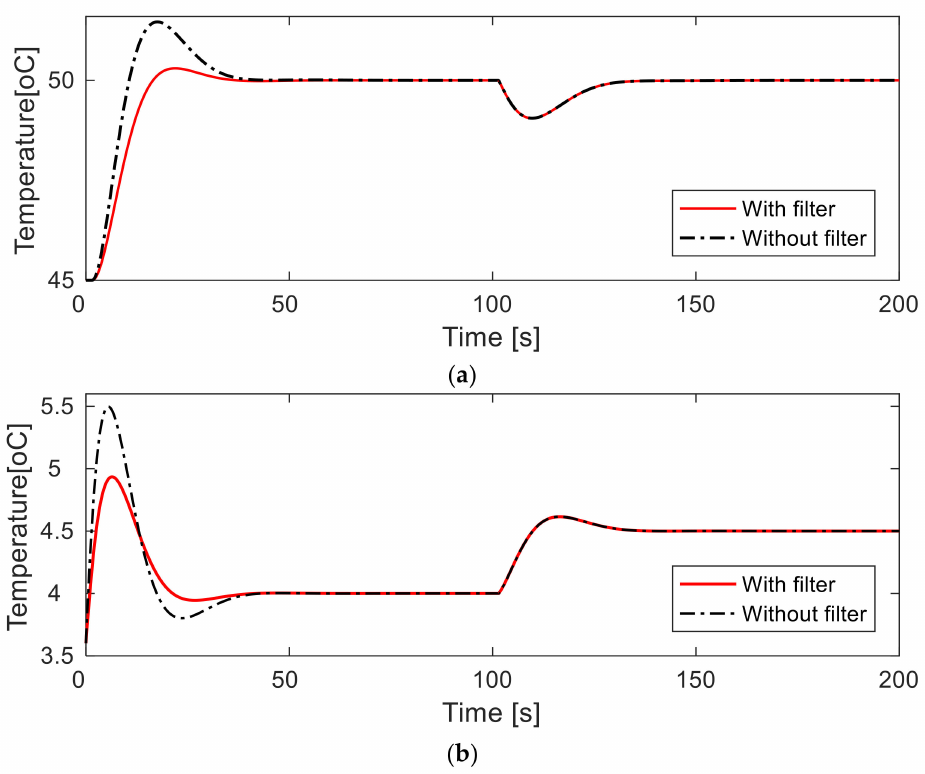
Figure 8. Step responses and steam flow rate for nominal heat exchanger. ( a ) Step responses; ( b ) steam flow rate. Table 5. Effect of set-point filter for nominal heat